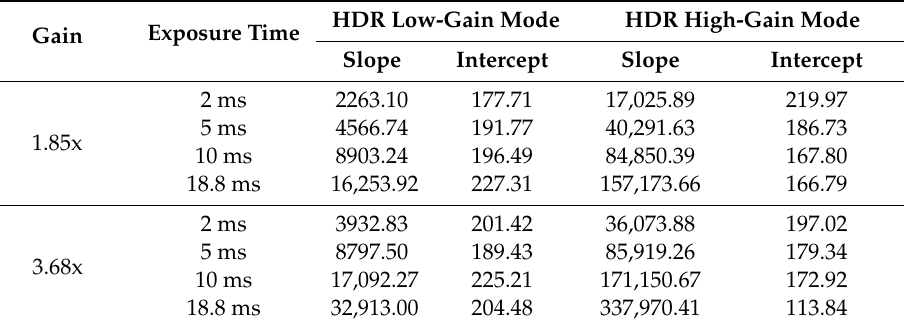
Table 5. Radiometric calibration e ffi ciency under various detector settings.